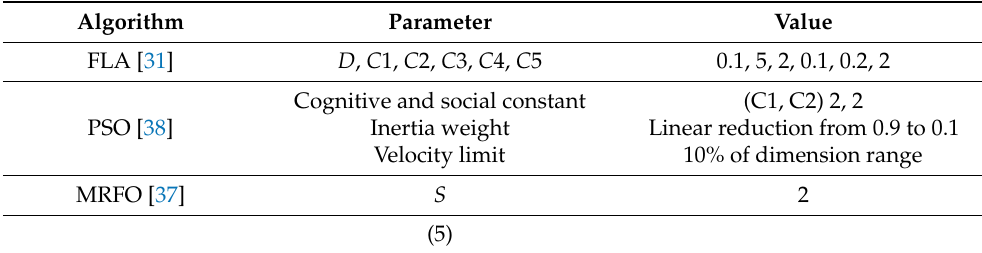
Table 1. Parameters of various algorithms under study.